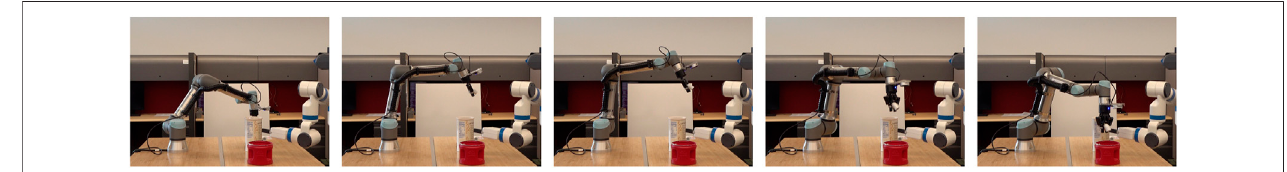
FIGURE 14 | A UR5e robot executing the CLF/CBF-based ProMP controller